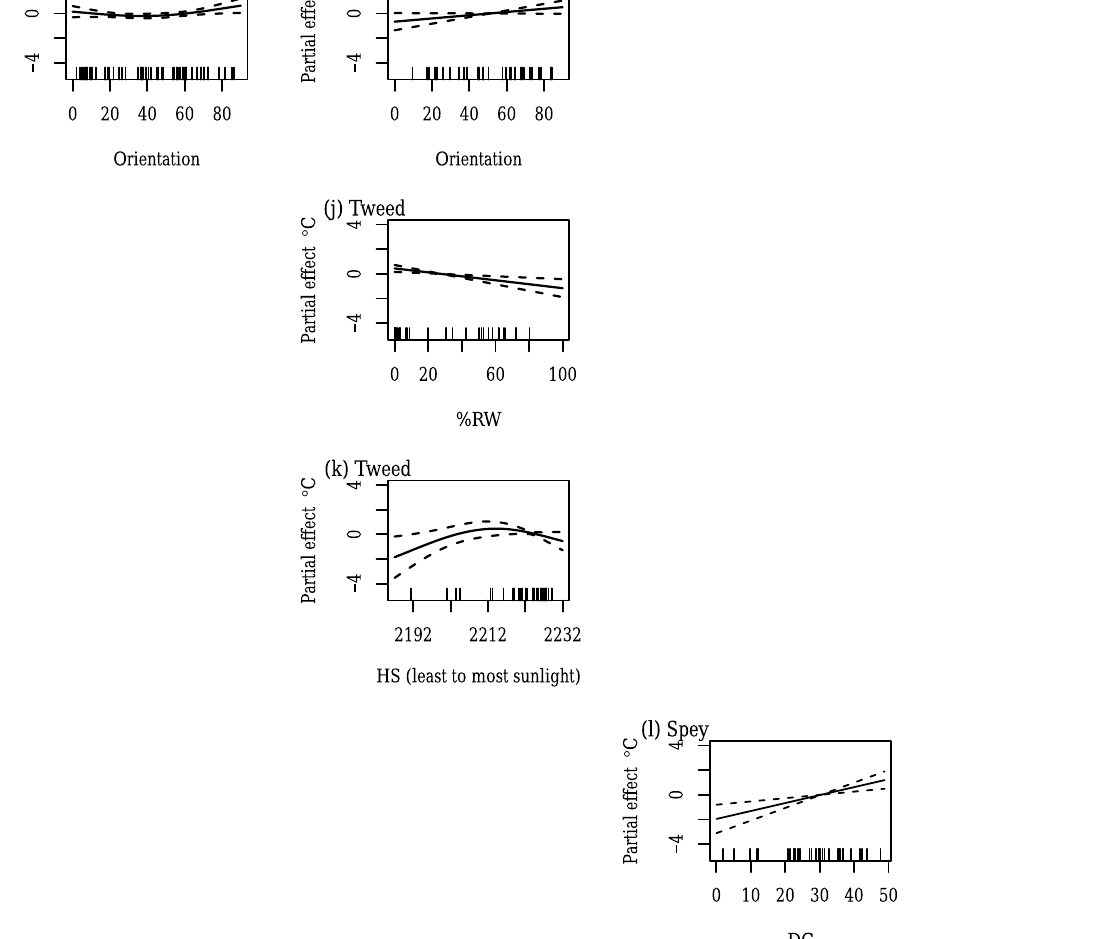
, (f) Tweed T a , (g) Bladnoch T a , (h) Dee Orientation, max max max